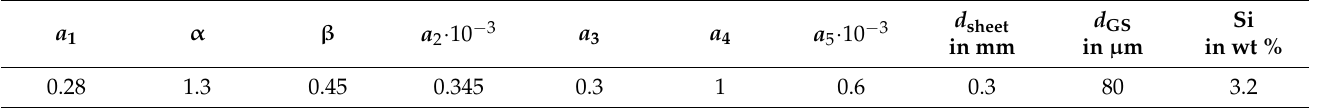
Table 5. Loss parameters and material parameters for the tailor-made material design